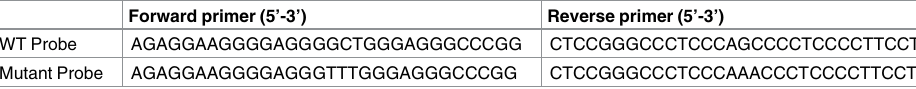
Table 4. DNA pull-down